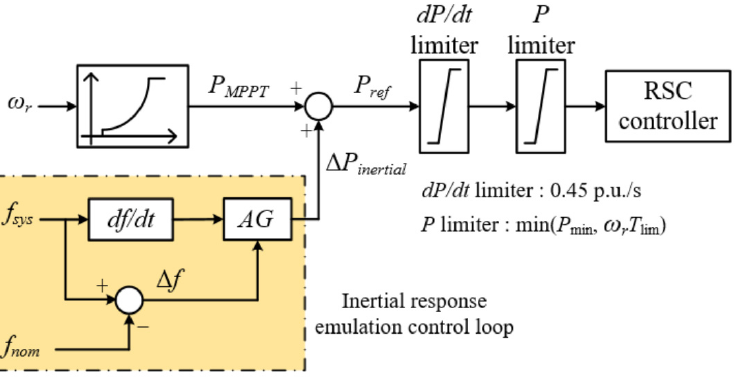
Figure 3. Control concept of the proposed adaptive inertial response emulated control scheme.